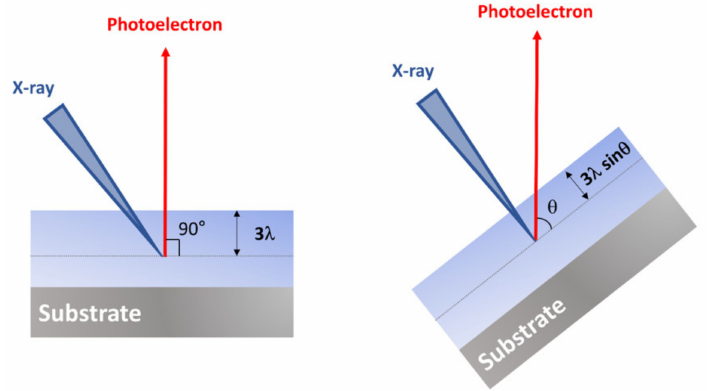
Figure 7. The changes in the e ff ective photoelectron escape depth in angle-resolved